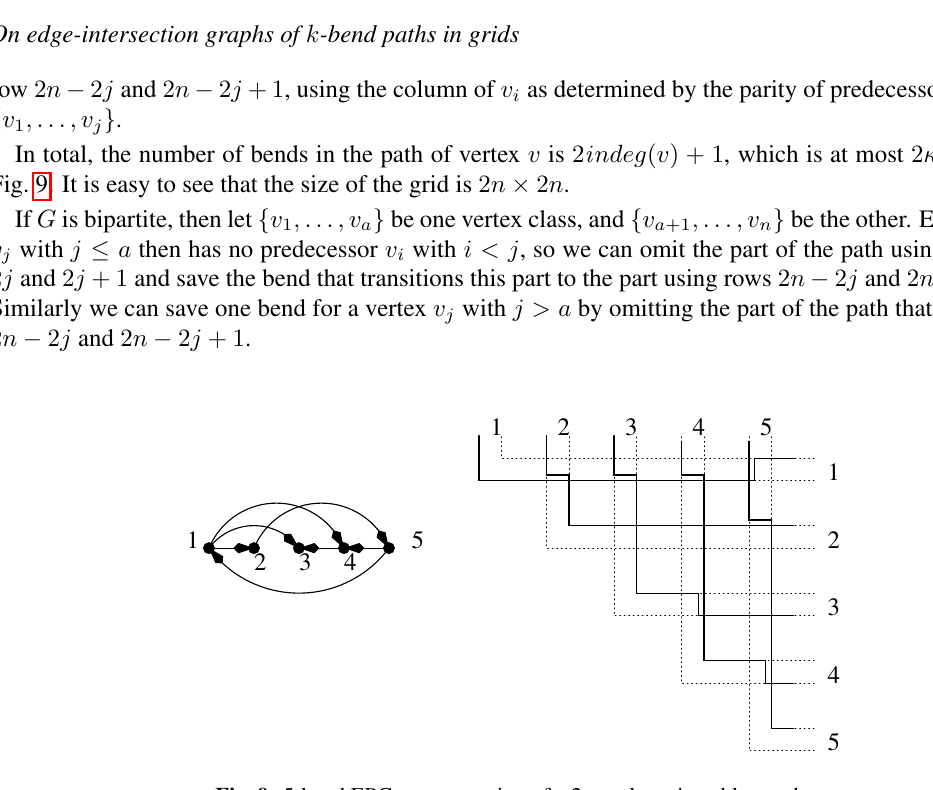
Fig. 9: 5-bend EPG representation of a 2-regular orientable